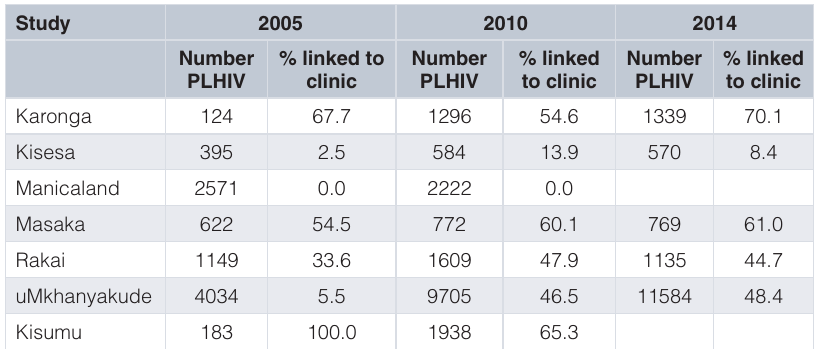
Table 3. Number of people living with HIV (PLHIV) and the percentage linked to clinical records by study and year.